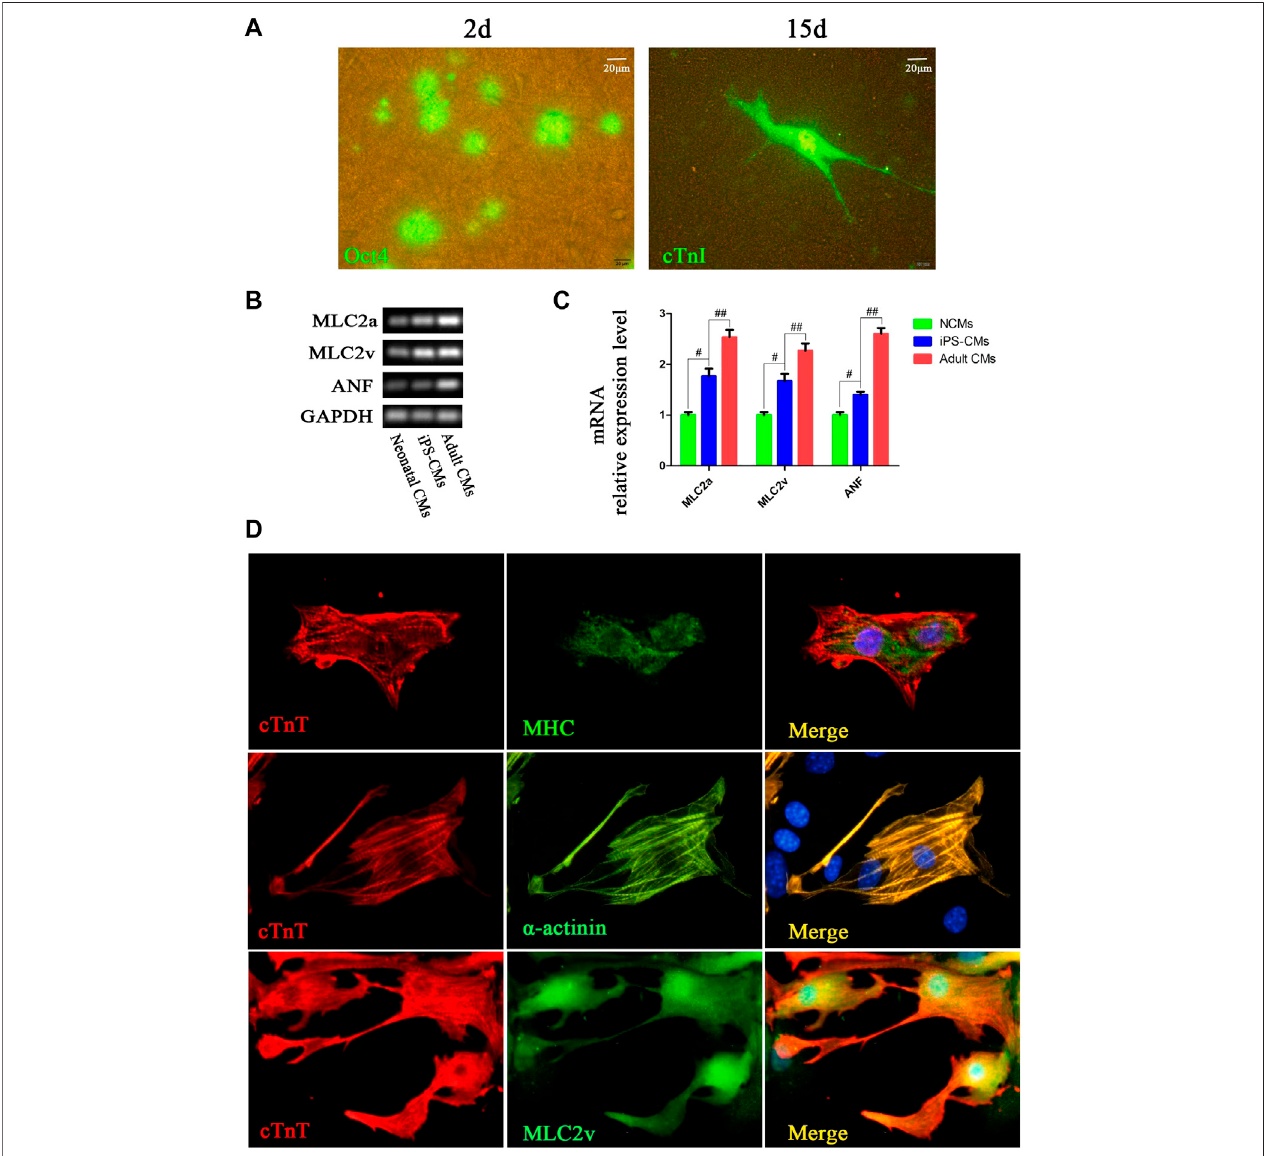
FIGURE 2 | CMs was differentiated from hPSCs cultured on 3D nano fi brous scaffold. (A) Fluorescence expression of Oct4 (day 2) and cTnI (day 15) in differentiation. (B,C) RT-PCR analysis of cardiac-speci fi c gene expression in differentiated iPSC-CMs cultured with 3D nano-scaffolds, NCMs and adult CMs. (D) Immuno fl uorescence co-staining of cTnT with MHC, α -actinin and MLC2v in cells at day 15 of differentiation on 3D nano fi brous scaffolds to identify the CM phenotype.